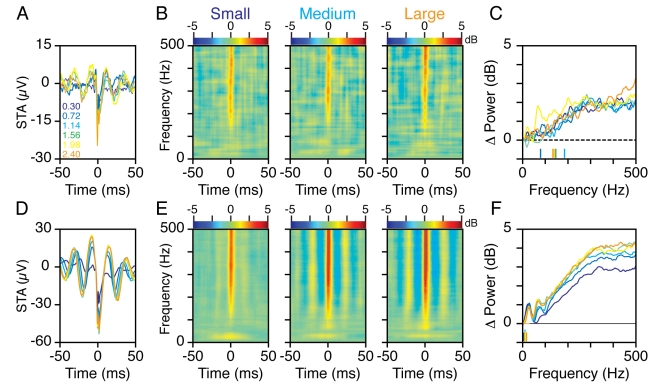
Spike-triggered average in time-frequency domain during stimulus
presentations.(A) Mean spike-triggered average of 15 sites for Monkey 1 for which at
least 25 spikes were available between 232 and 368 ms after stimulus
onset, for the six stimulus sizes. (B) The normalized STTFA (see text
and Figure 7 for
details) when a small (left), medium (middle), and large (right)
stimulus was presented. (C) The difference between the mean energy
between −1 and 3 ms of the STTFA and rSTTFA (same as the lower
panel of Figure 7C),
for the six stimulus sizes. The horizontal lines at the bottom indicate
the “cutoff frequency” for each stimulus size (see text for
definition). (D–F) Same as (A–C), for 94–103 sites in
Monkey 2 for which at least 25 spikes could be obtained. The number of
sites decreases from 103 to 94 because the firing rates decrease with
increasing stimulus size.